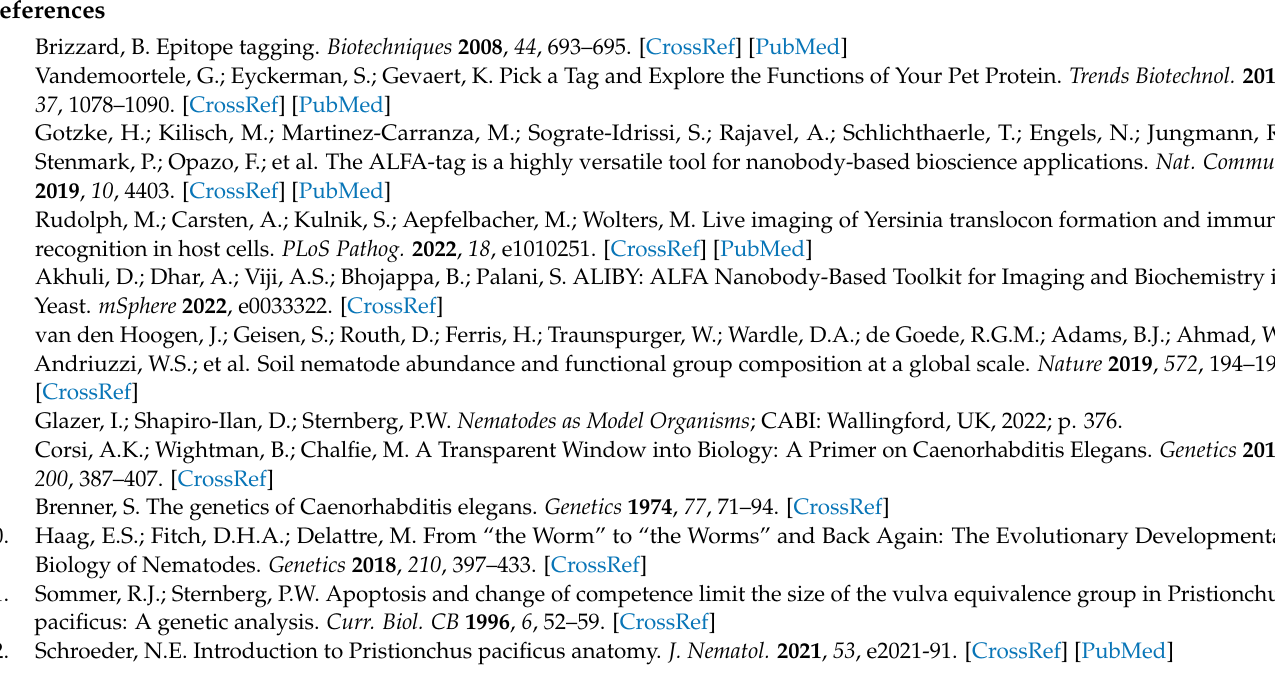
Table S2: Primer sequences used in this